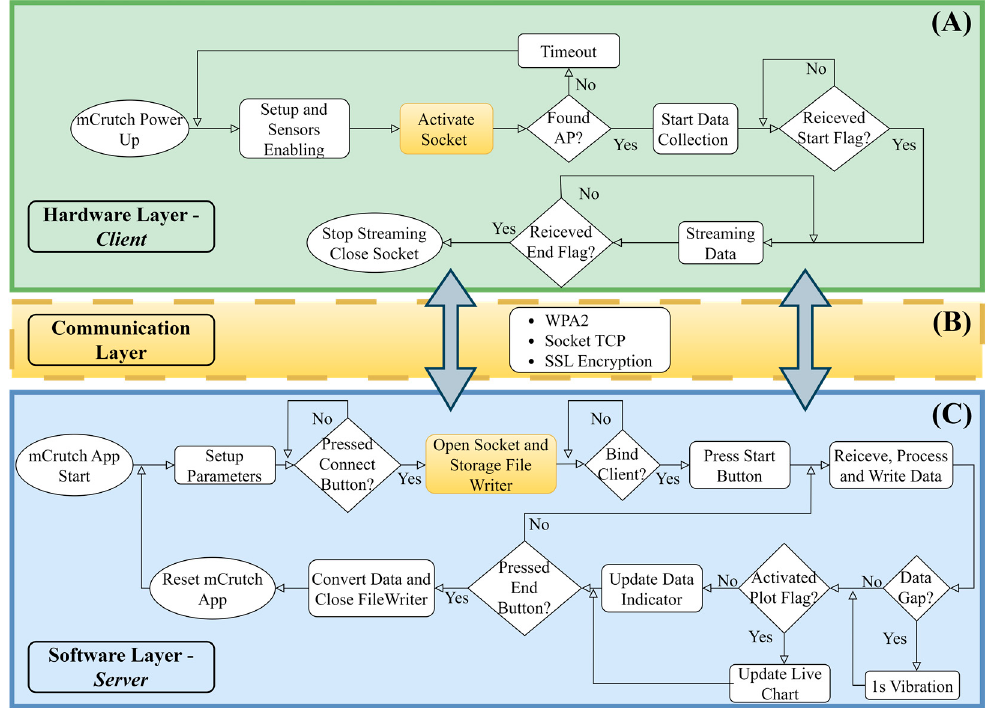
Figure 6. Layers of the mCrutch system architecture. The fi gure shows the fl owcharts of the Ar- duino/data collection layer ( A ), the communication layer ( B ), and the mCrutch app layer ( C